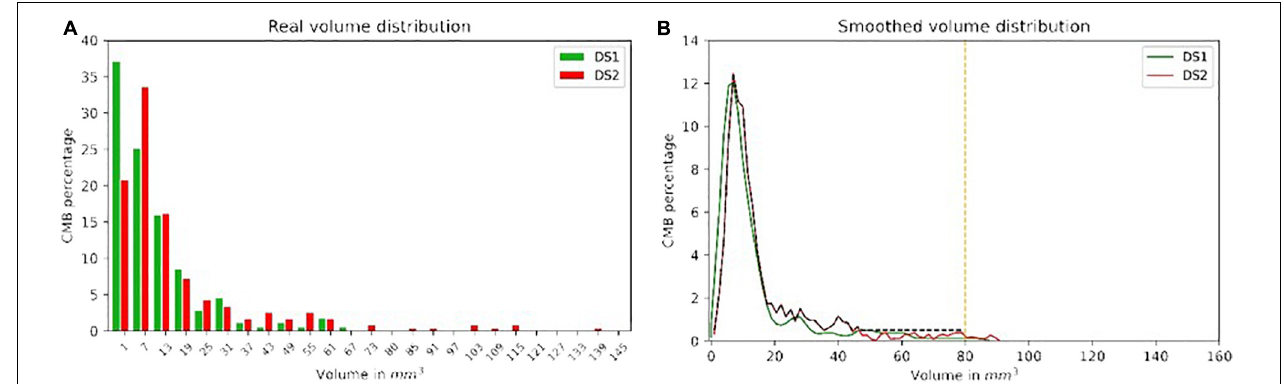
FIGURE 3 | The real and smoothed volume distribution from both DS1 (A) and DS2 (B) with green and red color, respectively. The black dash line shows the distribution ultimately used to generate the sCMB from